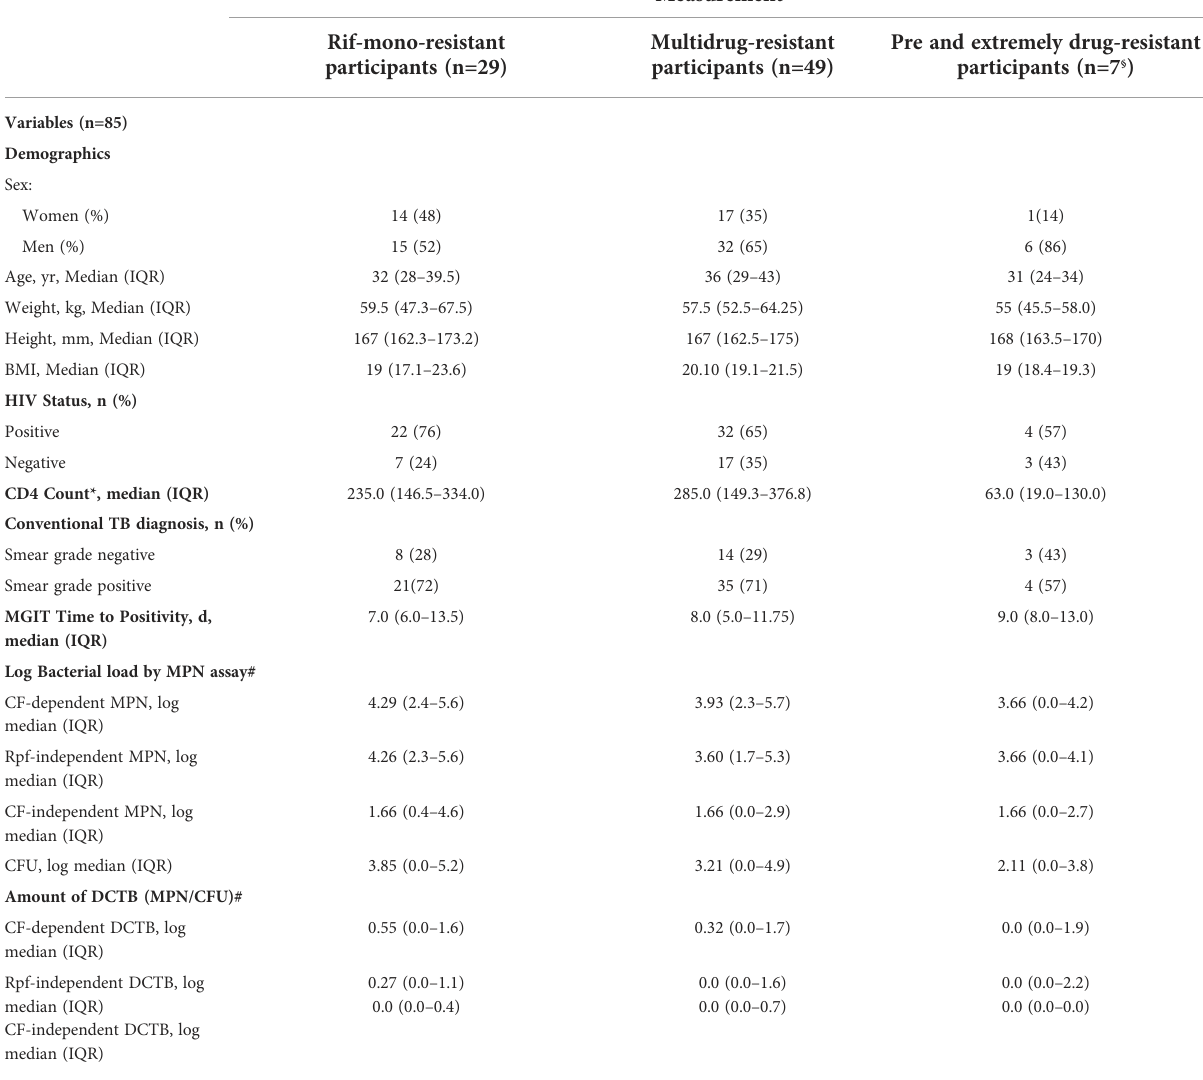
TABLE 1 Demographics and laboratory diagnostic data for study